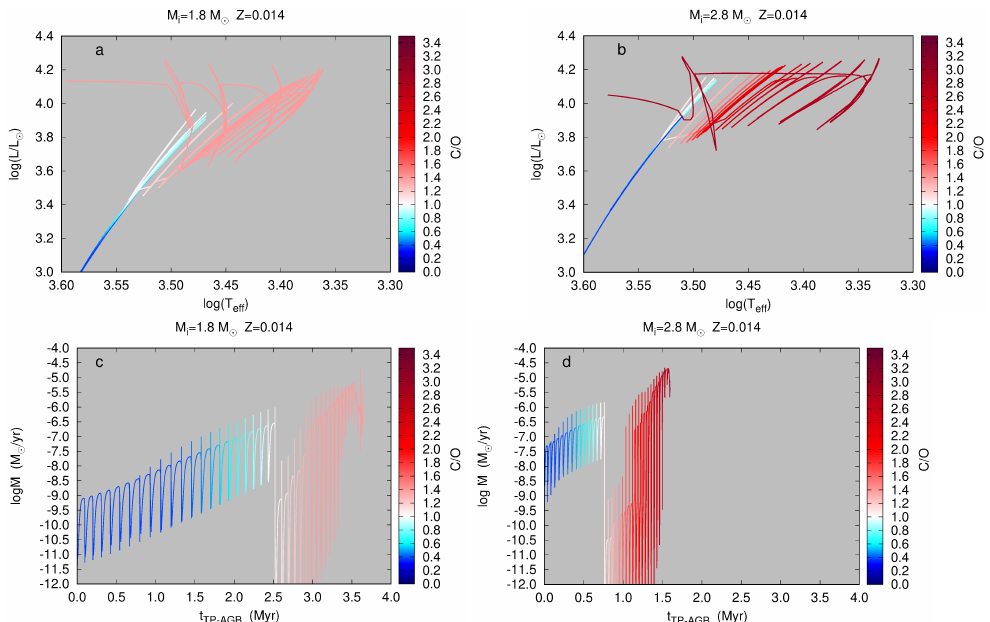
Figure 1. Impact of carbon enrichment on the evolution of TP-AGB stars. Two models are shown as an example, namely M i = 1.8M (cid:12) (left panels) and M i = 2.8M (cid:12) (right panels), which reach approximately the same final mass, M f (cid:39) 0.70 − 0.71M (cid:12) at the end of the TP-AGB phase. ( a , b ) Evo- lution on the H-R diagram during the whole TP-AGB evolution, color-coded according to the current photospheric C/O ratio. ( c , d ) Evolution of the mass-loss rate. Time is set to zero at the first TP. The tracks are color-coded according to the current photospheric C/O ratio. The drop in mass loss during the carbon-star phase occurs when the carbon excess, C − O, is below the current threshold to trigger a dust-driven wind. See the text for more